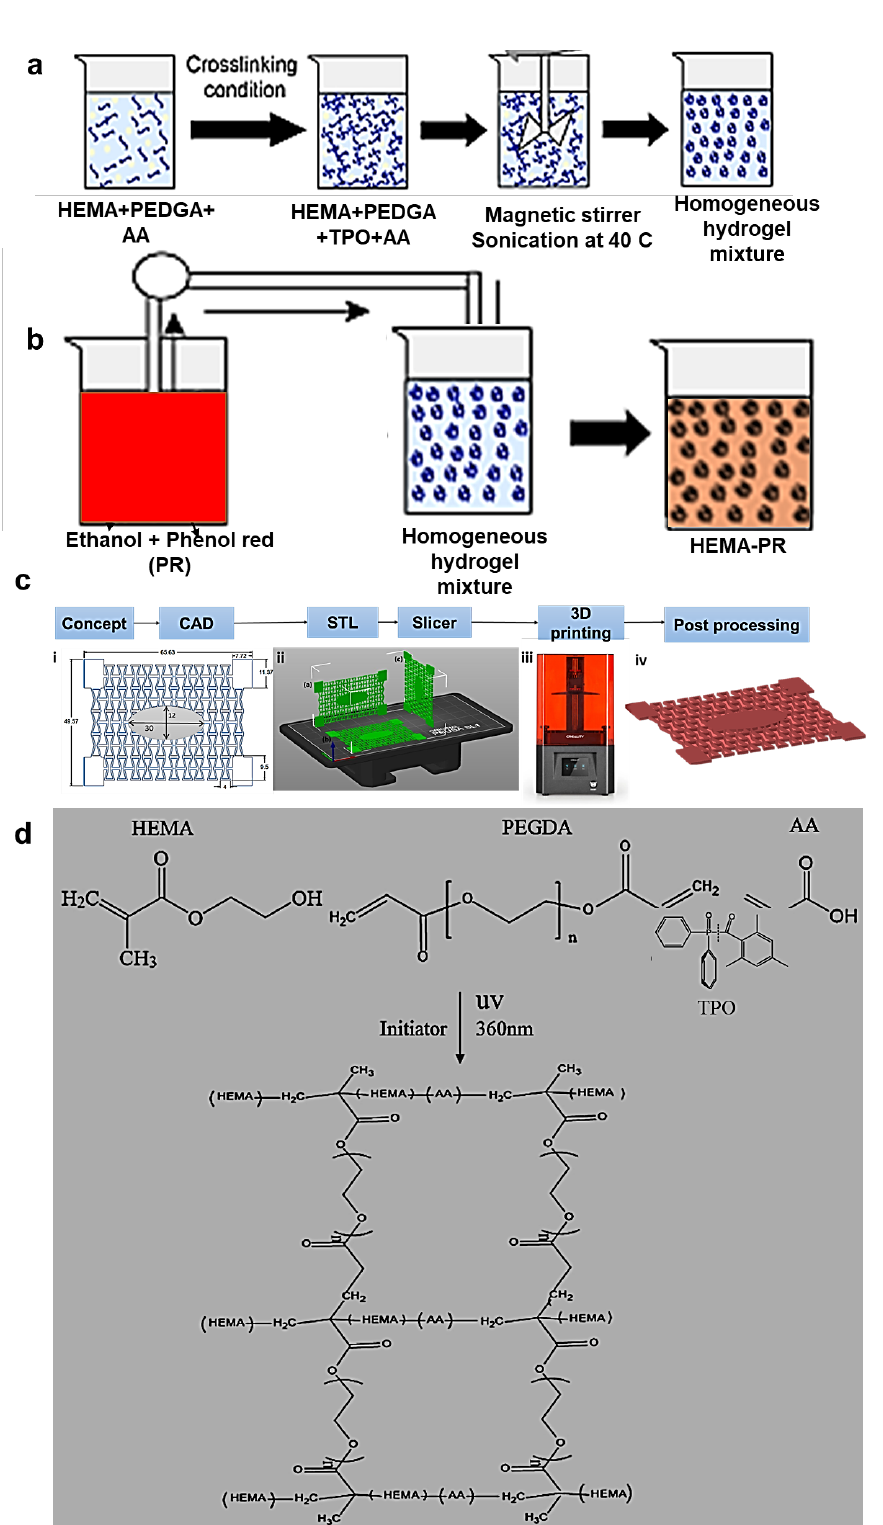
Figure 8. ( a ) Hydrogel resin preparation ( b ) Dissolving of phenol red (PR) in ethanol ( c ) Additive manufacturing process from initial concept to the final printed hydrogel wound dressing ( d ) Chemical synthesis of the HEMA/PEGDA/TPO/AA.